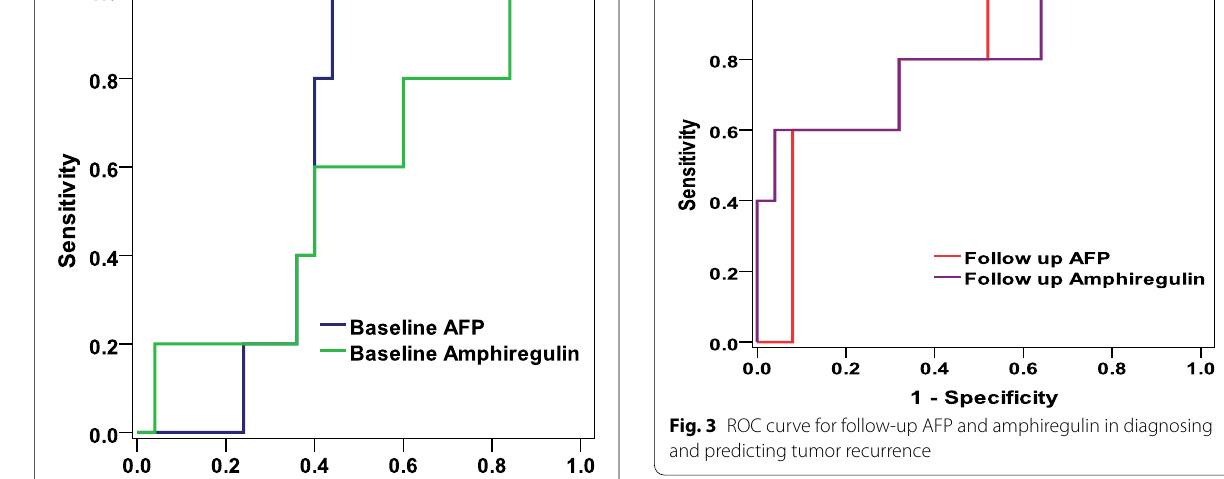
Table 11 Diagnostic performance of follow-up AFP and amphiregulin in diagnosing tumor recurrence Marker AUC